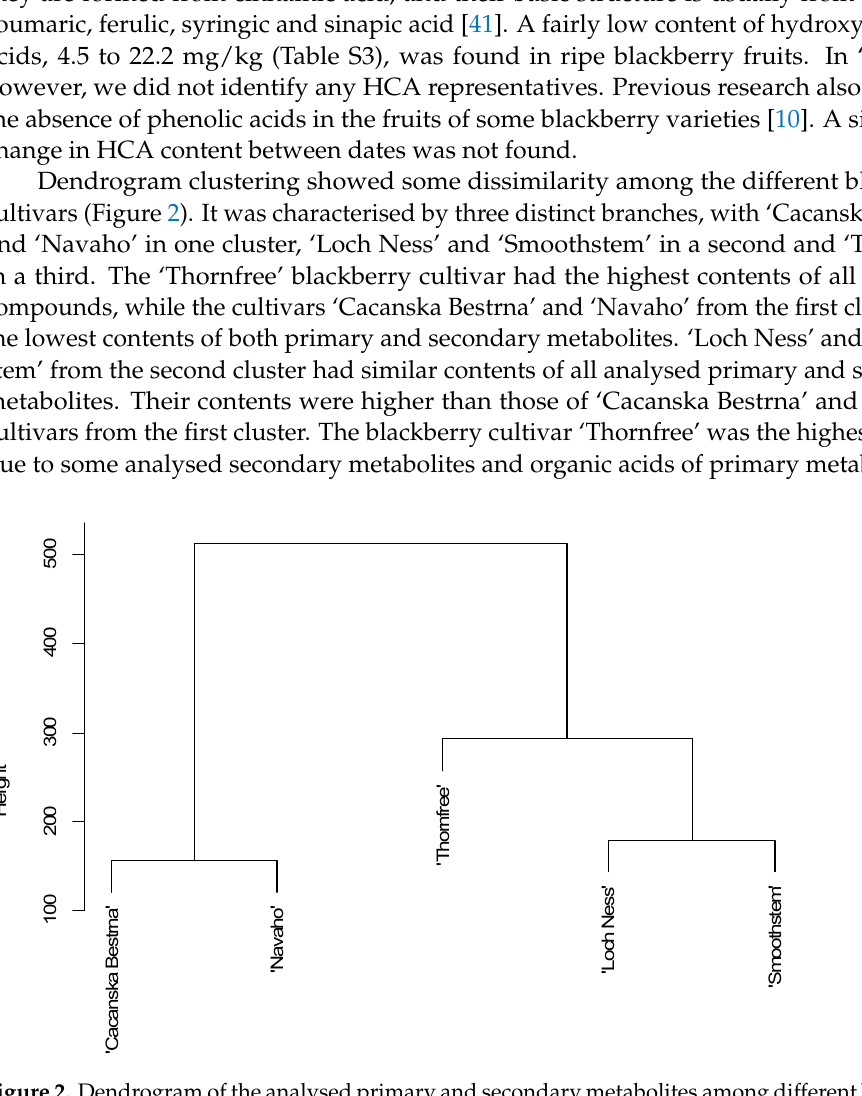
Figure 2. Dendrogram of the analysed primary and secondary metabolites among different blackberry cultivars, using Ward’s method, based on the square Euclidean distance.